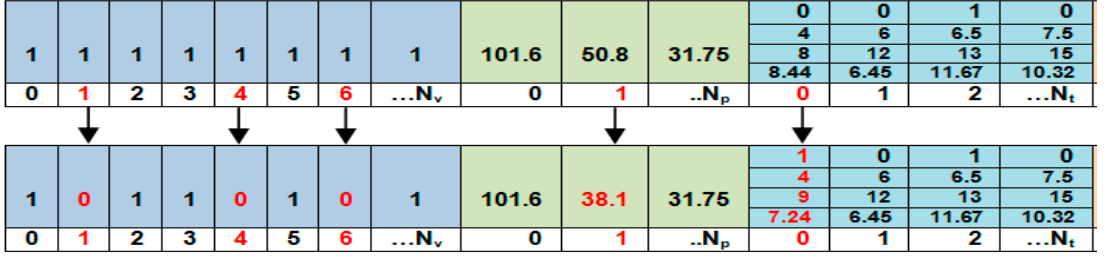
Figure 7. Mutation operator procedure.